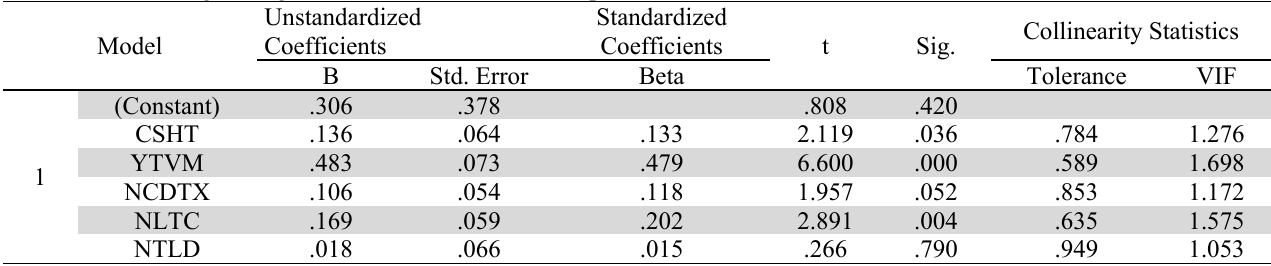
Results of estimating the regression coefficient with the dependent variable of level 3